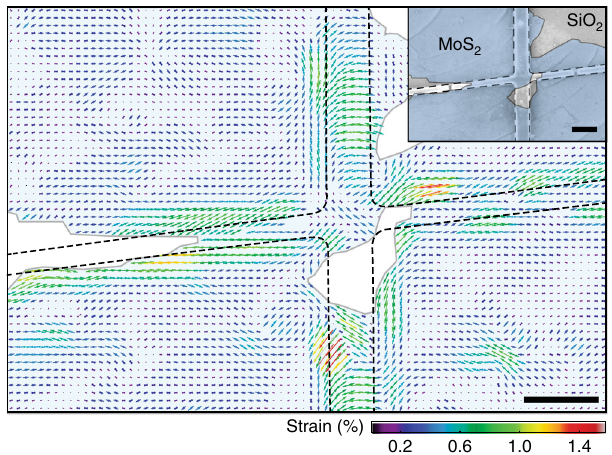
Fig. 4 Strain imaging. Uniaxial strain map of MoS 2 monolayer fl ake ( fi lled color) on a lithographically de fi ned structure (dashed lines). Arrows: measured uniaxial strain fi eld. Inset: SEM image of sample. Scale bars, 1 μ m